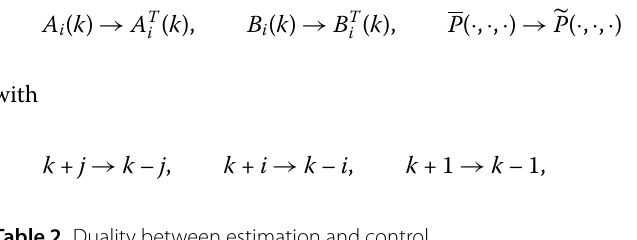
Table 2 Duality between estimation and control LMMSE